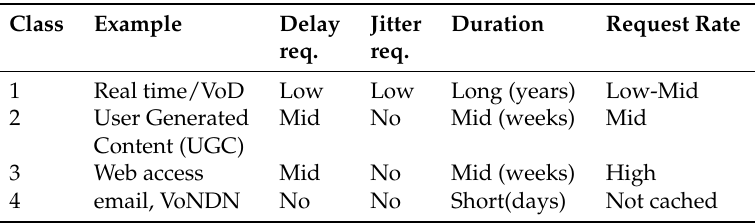
Table 1. Class of content